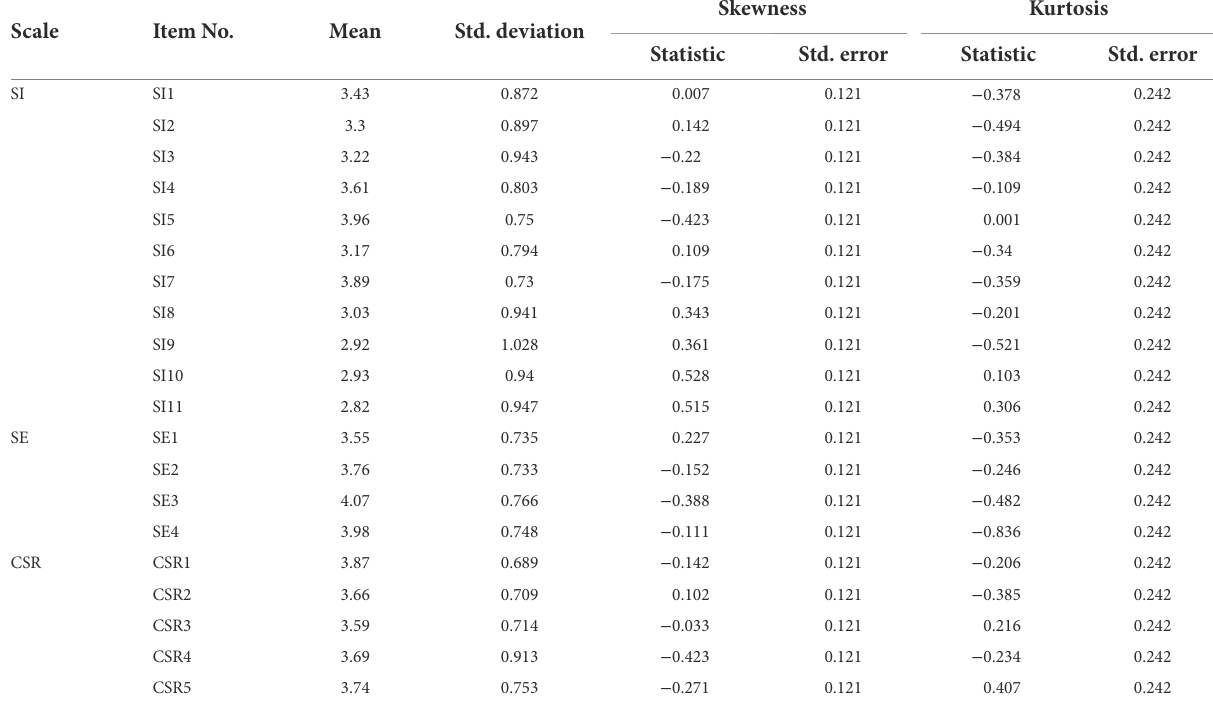
TABLE 2 Descriptive